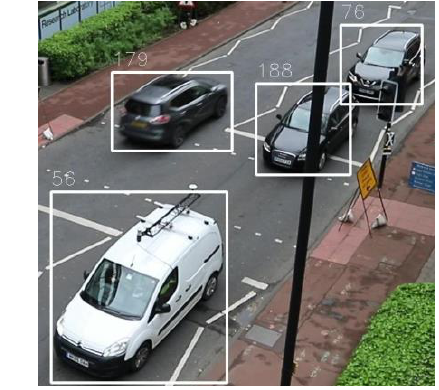
Figure 4. Detection and tracking outcomes, with bounding box detections (white), and tracking ID numbers (top left of bounding boxes, white)